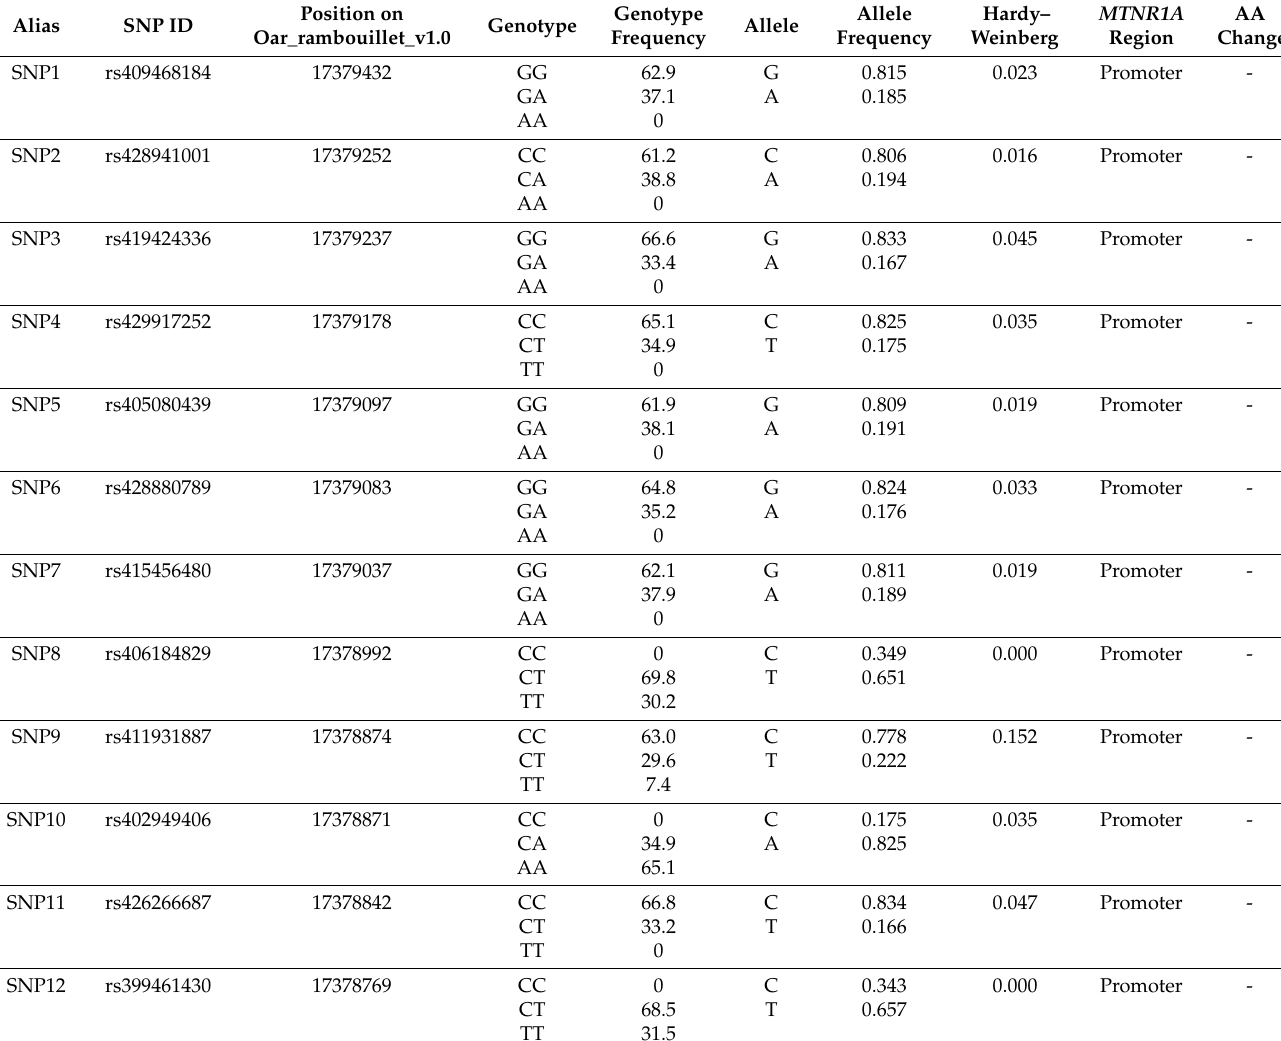
Table 1. Number and ID of single nucleotide polymorphisms (SNPs), genotype, allele frequency, Hardy–Weinberg equilibrium, locus, and amino acid (AA) change in the MTNR1A gene. The sequence is in a reverse orientation on the genome, and the SNPs are ordered according to their positions in the latest sheep genome version (Oar_Rambouillet_v1.0,